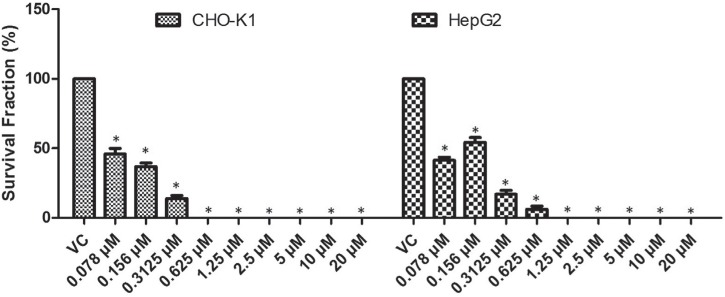
Clonogenic assay showing the survival fraction of CHO-K1 and HepG2 cell lines after 24 h treatment with different concentrations of cis-TMS. Cells were treated for 24 h and allowed to grow during seven consecutive days. NC: negative control. *p < 0.05 compared to vehicle control.